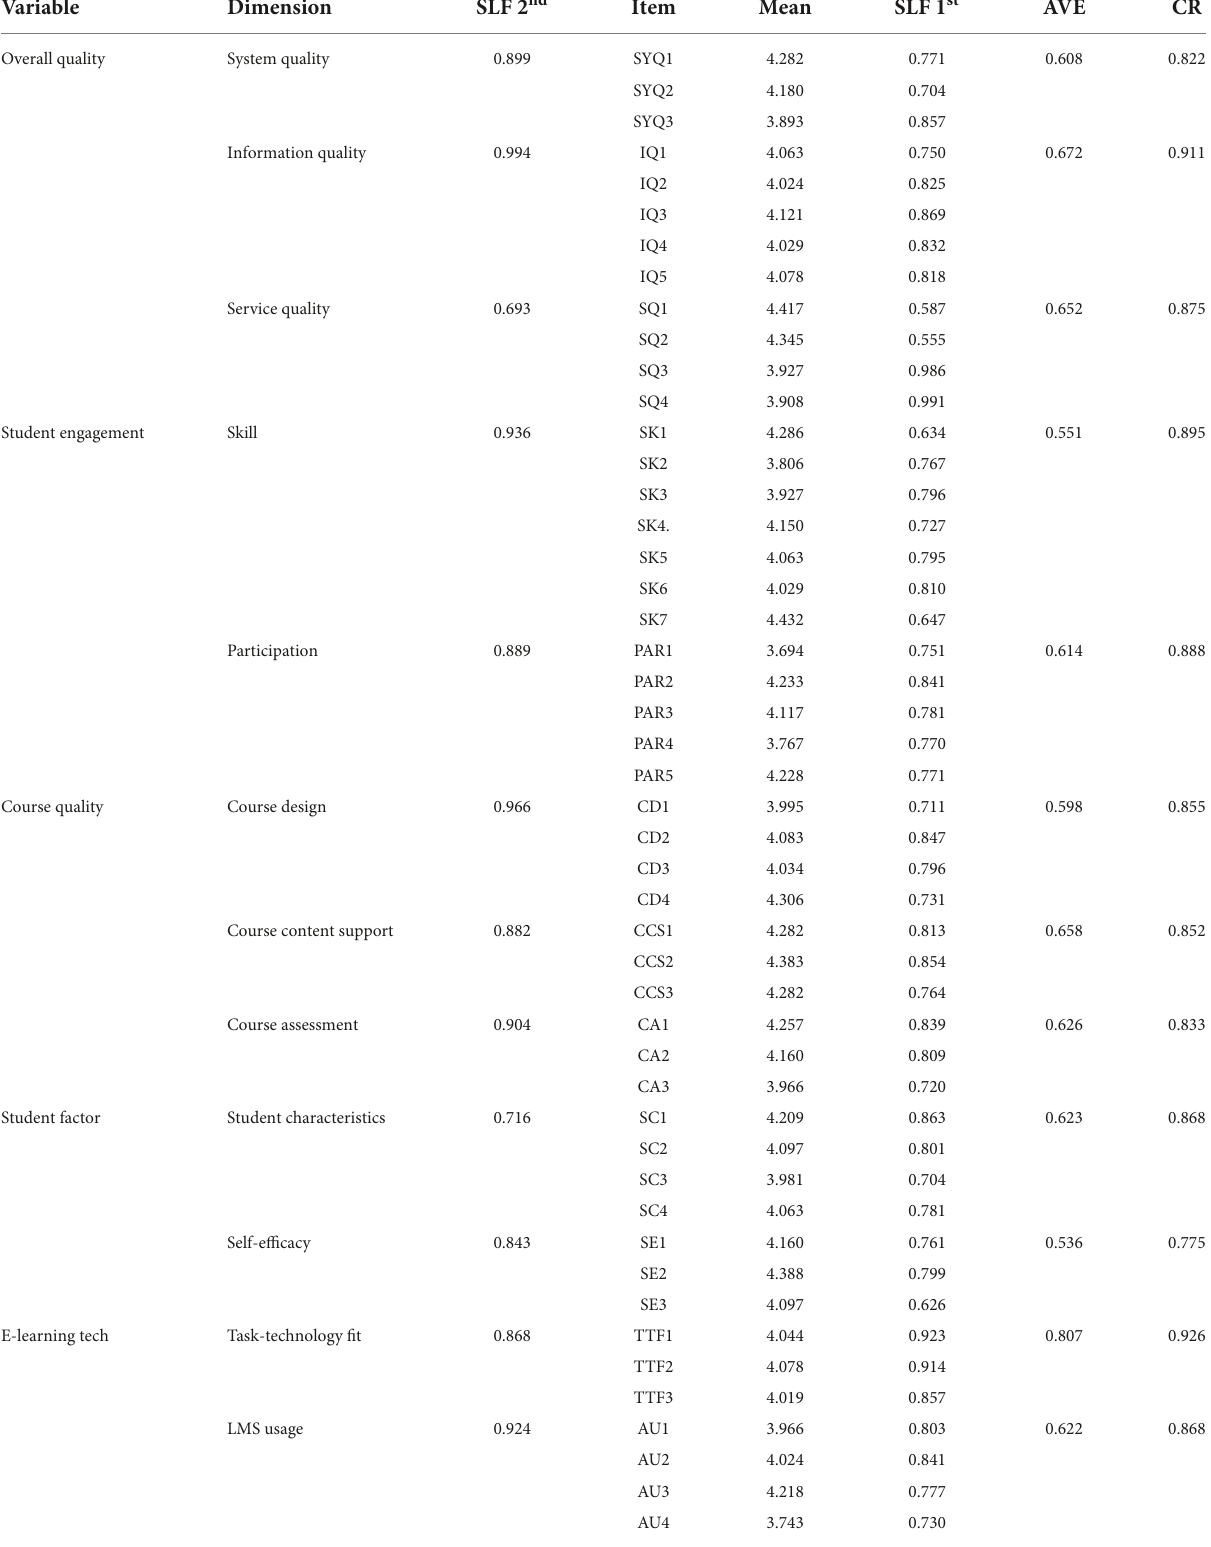
TABLE 3 Confirmatory factor analysis and internal consistency—second